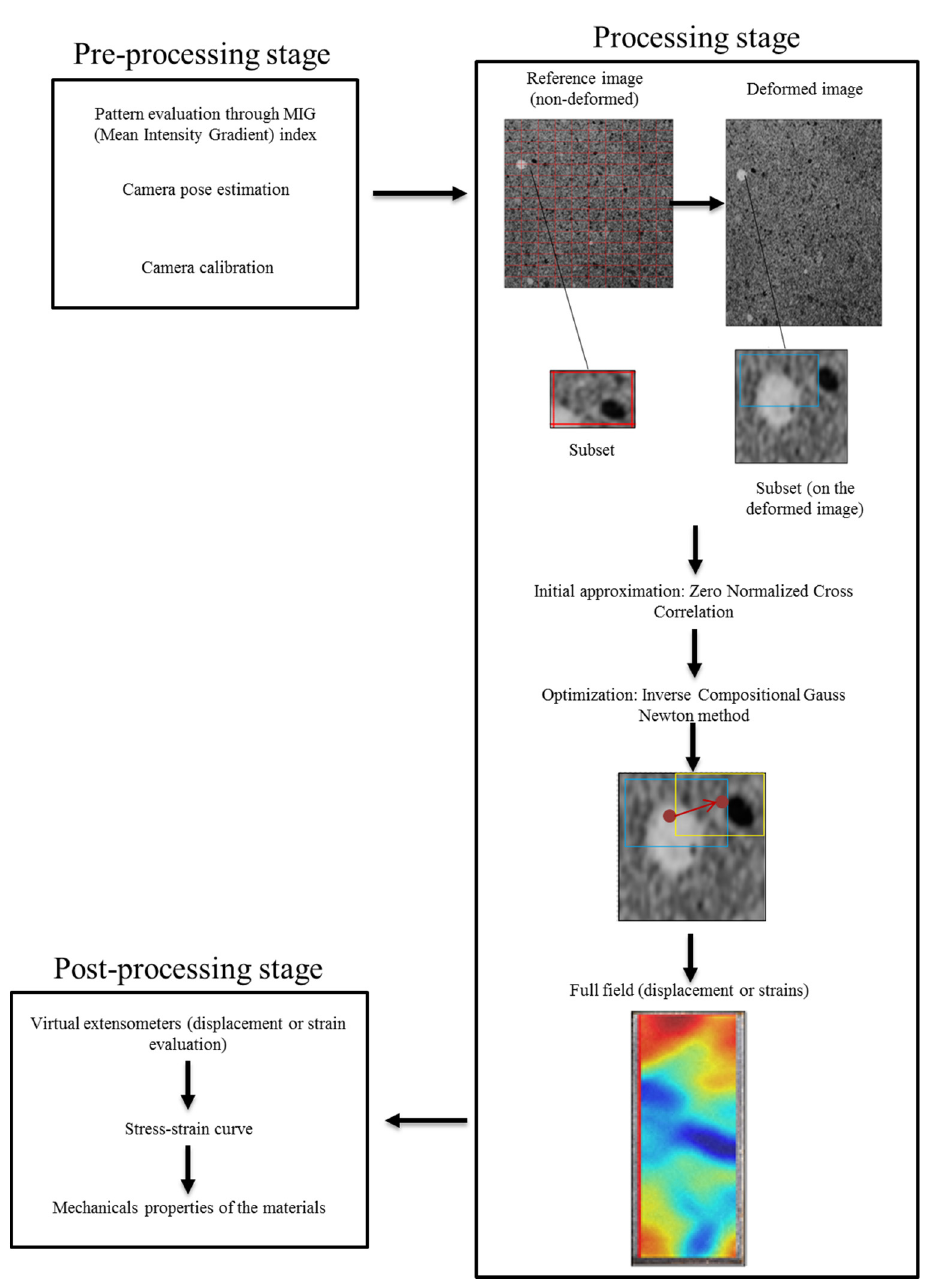
Figure 2. Digital Image Correlation general outline. In red the reference subset, in blue the initial seed, and in yellow, the final location of the subset.